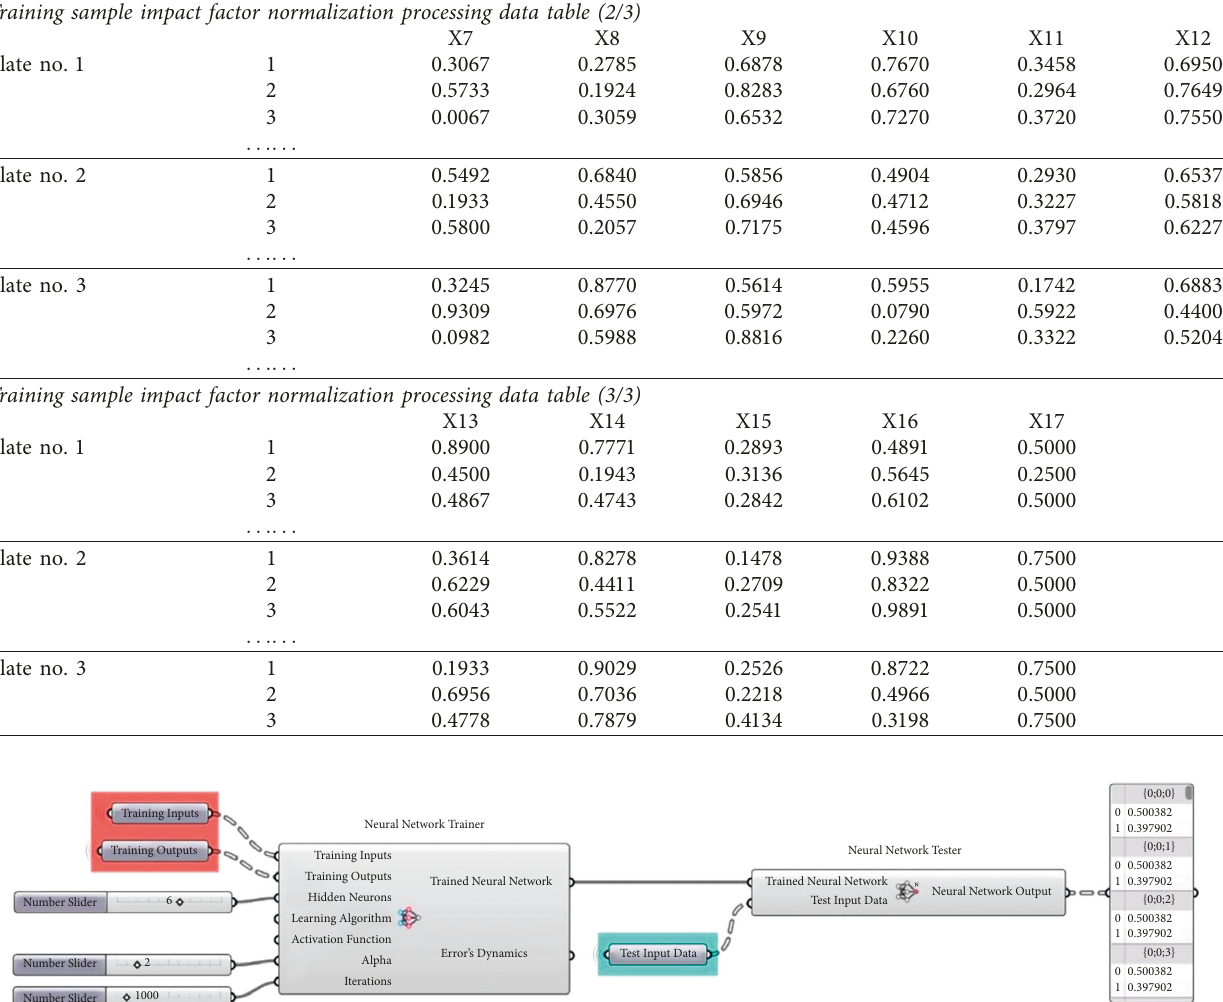
Figure 13: External connection of the “Neural Network Trainer” and “Neural Network Tester”